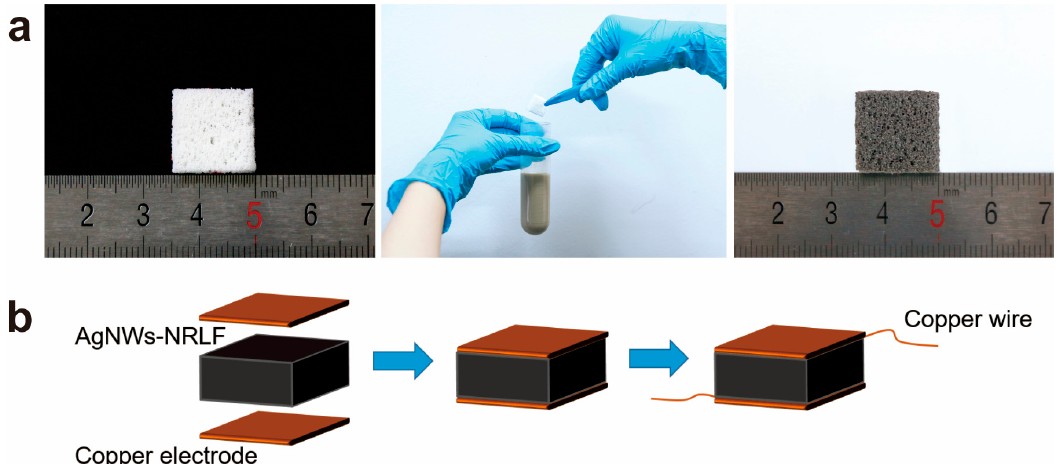
Figure 2. Preparation of AgNWs / NRLF pressure sensor. ( a ) Schematic illustration of the fabrication procedure of AgNWs / NRLF. ( b ) Schematic of the fabrication process of AgNWs / NRLF pressure sensor.